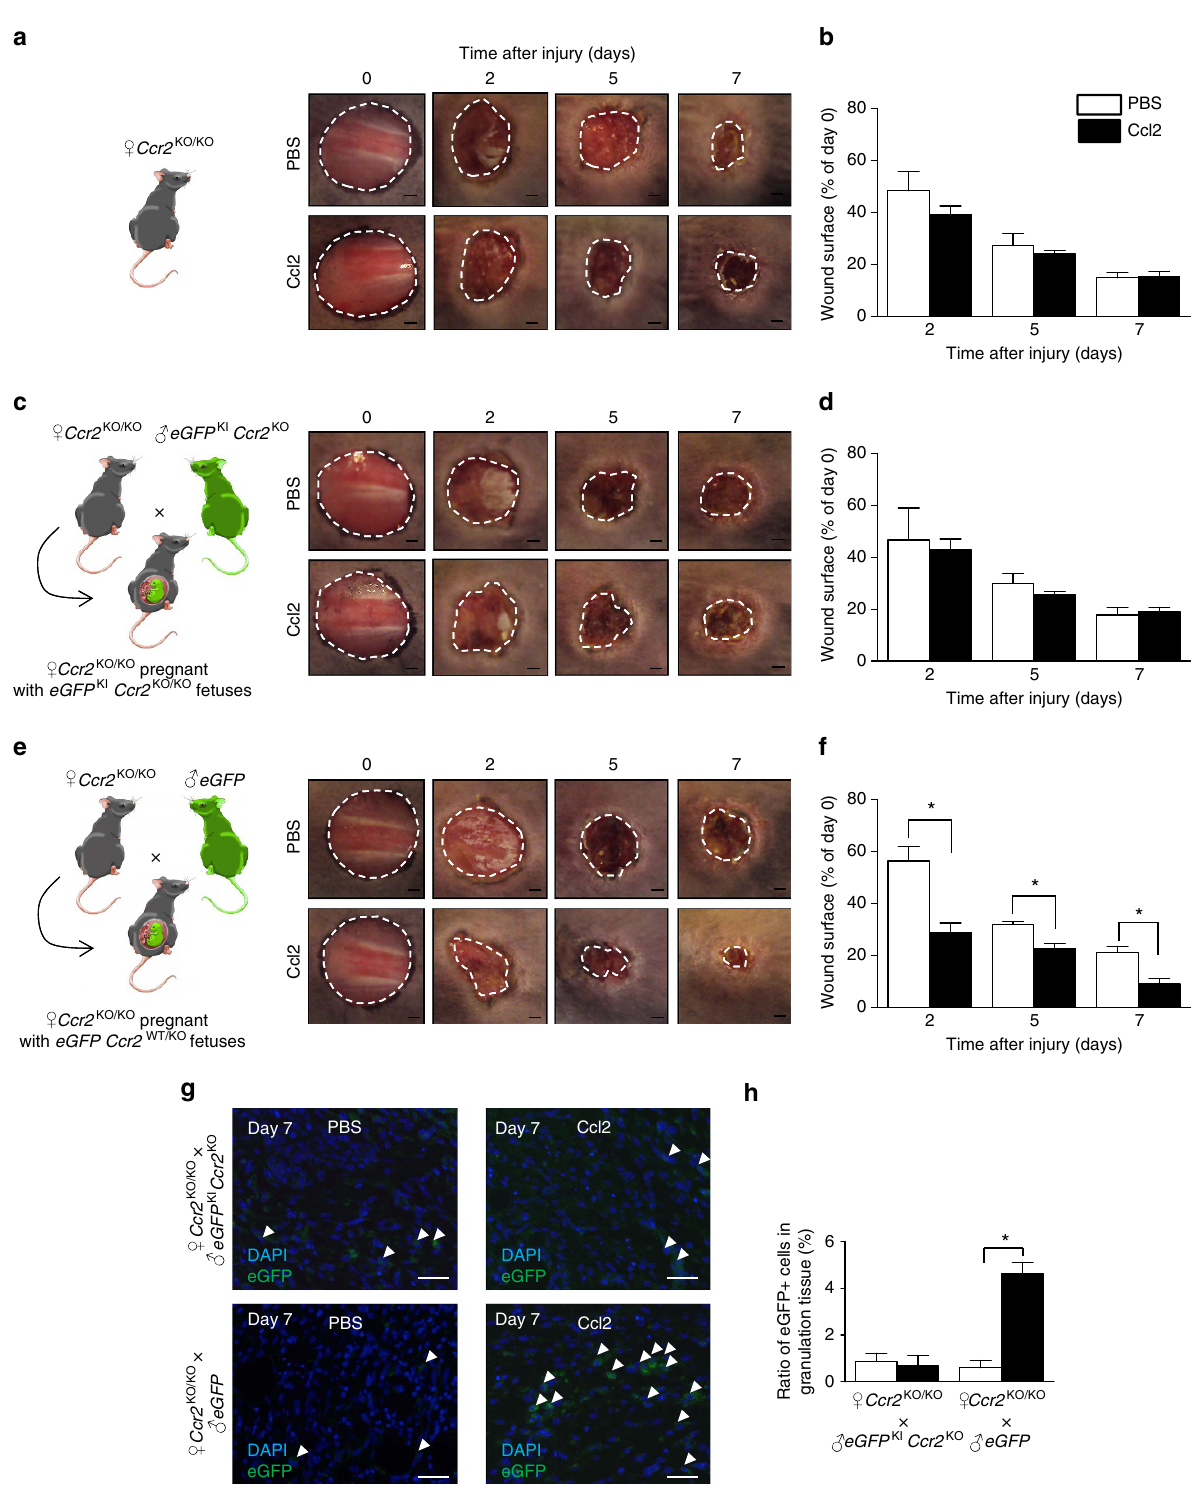
Figure 3 | FMCs are recruited to maternal wounds through Ccl2/Ccr2 pathway. An 8mm wound was created in pregnant female mice carrying eGFP þ foetuses. We injected Ccl2 or PBS into the wound immediately and 2 days after skin excision. ( a ) Experimental design and time course of skin wound healing from Ccr2 KO/KO virgin mice. ( b ) Planimetry of the wound area relative to the initial wound area at various time points from Ccr2 KO/KO virgin mice ( n ¼ 5). ( c ) Experimental design and time course of skin wound healing from Ccr2 KO/KO female mice mated with eGFP KI Ccr2 KO male mice. ( d ) Planimetry of the wound area relative to the initial wound area at various time points from Ccr2 KO/KO female mice mated with eGFP KI Ccr2 KO male mice ( n ¼ 5). ( e ) Experimental design and time course of skin wound healing from Ccr2 KO/KO female mice mated with eGFP male mice. Scale bars, 1mm. ( f ) Planimetry of the wound area relative to the initial wound area at various time points ( n ¼ 5) from Ccr2 KO/KO female mice mated with eGFP male mice. ( g ) Representive micrographs of the spontaneous fluorescence of eGFP þ (green) cells in granulation tissue indicated by white arrowheads. Scale bars, 50 m m. ( h ) Quantifications of eGFP þ cells in sections of wounds from pregnant mice after injections of PBS or Ccl2 ( n ¼ 3). Student’s t -test, * P o 0.05; mean ±